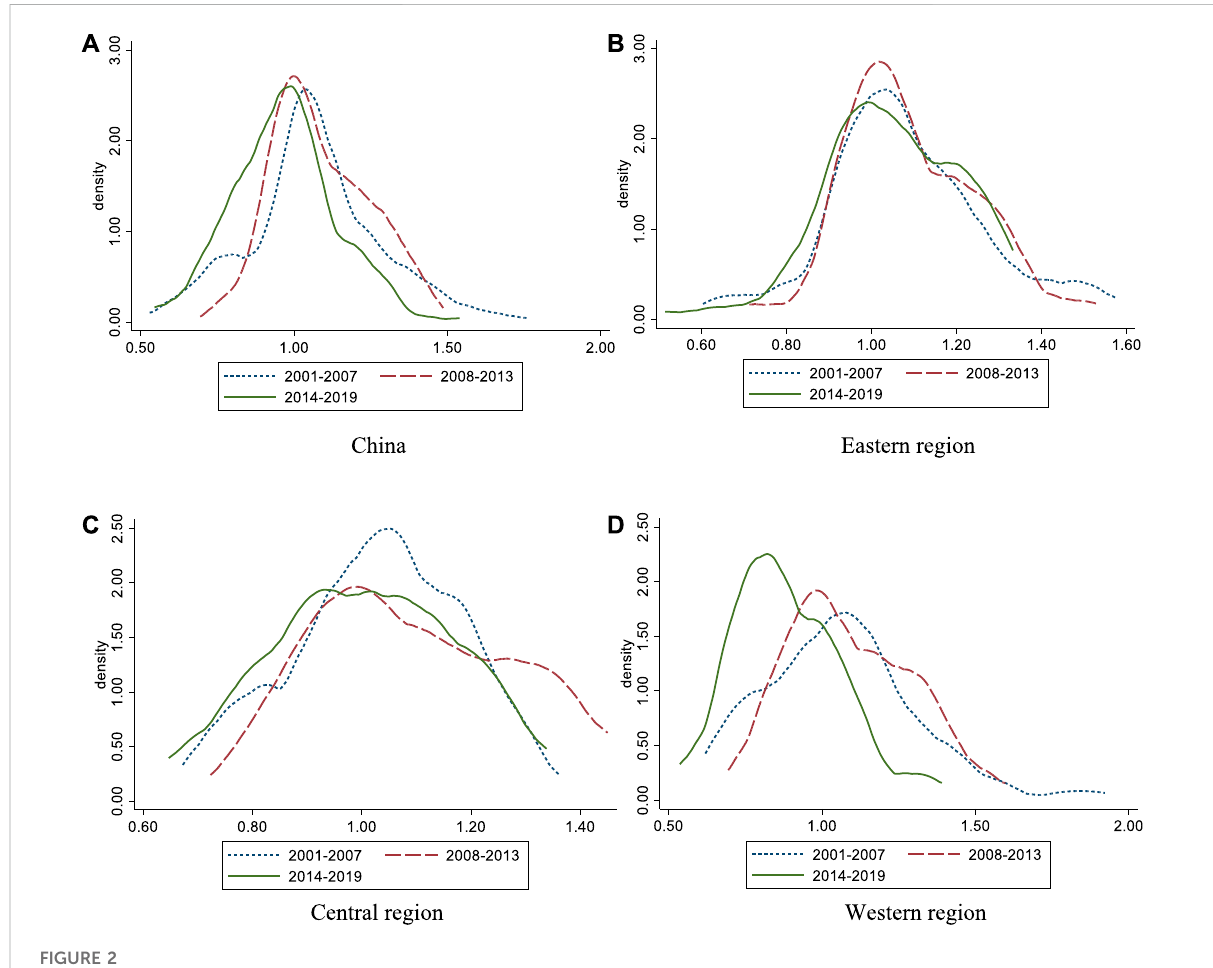
FIGURE 2 Dynamic evolution of ML . (A) China, (B) Eastern region, (C) Central region, (D) Western